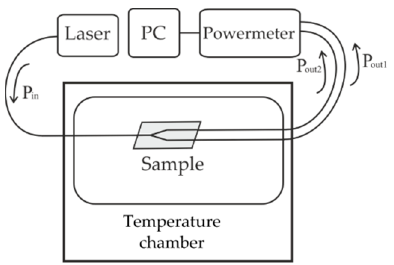
Figure 2. Scheme of the experimental assembly for optical measurements.